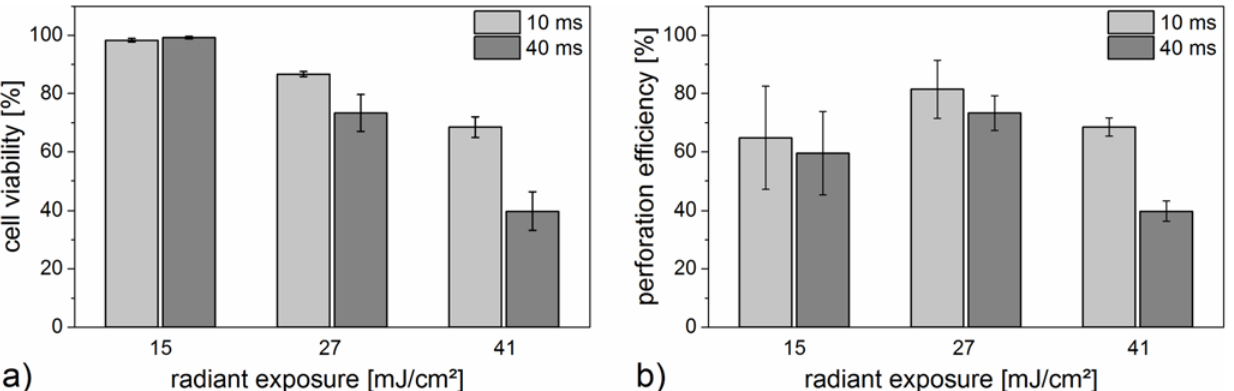
Fig 2. Cell viability (a) and perforation efficiency (b) for different radiant exposures and irradiation times. Viability was evaluated with a calcein/ propidium iodide assay one hour after perforation. The perforation efficiency was analyzed via uptake of propidium iodide one minute after laser perforation and is the product of perforated and viable cells. It decreases with higher radiant exposures. Highest perforation efficiency is achieved with 10 ms exposure time and 27 mJ/cm 2 . The mean and standard deviation of three independent measurements are shown. Each measurement consisted of thirty irradiated cell